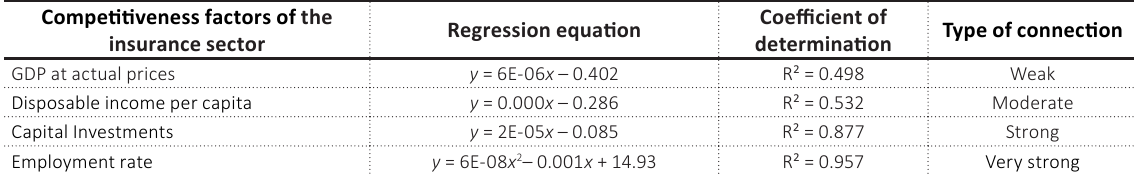
Table 4. Influence of economic factors on the competitiveness of the insurance sector Source: Compiled and calculated according to official requests to the State Statistics Service of Ukraine